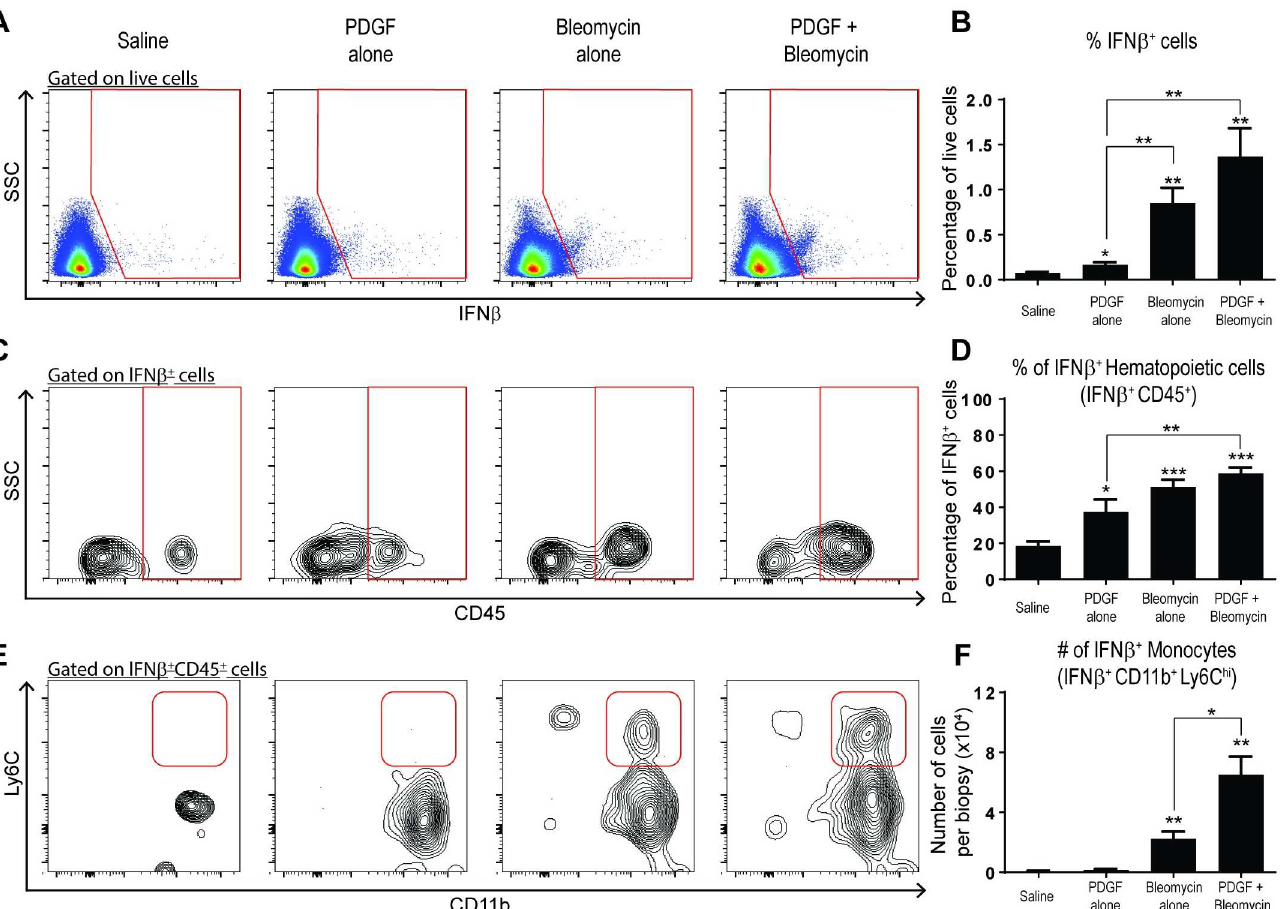
Fig 3. Myeloidcellsare a prominentsource of IFN β upontreatmentwiththe combinationof PDGF-BB+ bleomycin. Wildtypemice were treated with saline, PDGF-BB alone, bleomycin alone, or PDGF-BB + bleomycin were assessed for productionof IFN β by intracellularstainingon day 3 post- treatment.(A) Representative flow cytometricplots of intracellular stainingof IFN β + cells fromsingle-cell suspensions obtainedfromskin biopsiesare shown. (B) Proportionof totallive cells positive for IFN β .(C) Representative flow cytometricplots of IFN β -producing leukocytes (gatedIFN β + ). (D) Proportion of IFN β + cells that are leukocytes as definedby expression of CD45. (E) Representative flow cytometric plots of IFN β -producingmonocytes (gatedIFN β + CD45 + ). (D) Absolutenumberof IFN β -producing monocytesas definedby co-expressionof CD11b and Ly6C (gatedIFN β + CD45 + ). Data is representative of at least two experimentswith at least 5 mice/group/experiment. * P < 0.05, ** P < 0.01, *** P < 0.001,versus saline or for bracketed comparisons shown (student’s t